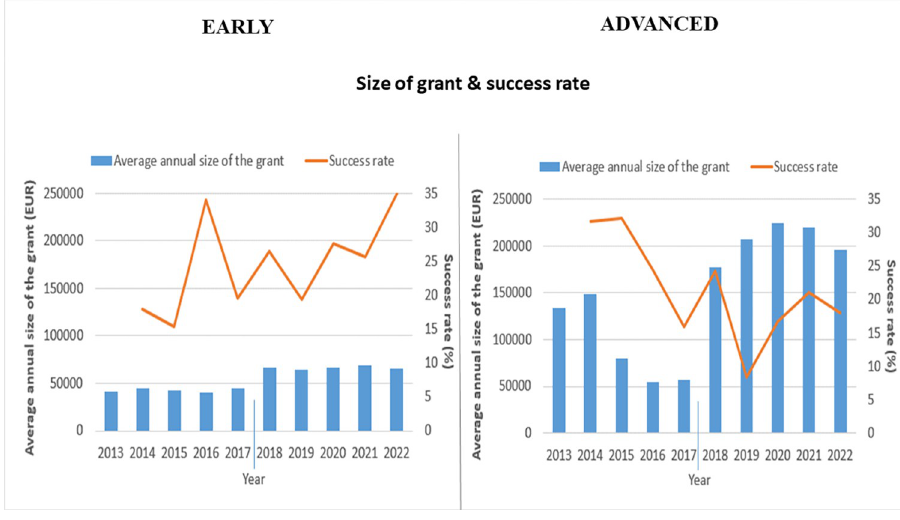
Fig 4. Yearly size of the grant and success rate for early-stage and advanced-stage grant types across all grants awarded by the Estonian Research Council between 2013–2022. The line between 2017 and 2018 indicates the change in grant